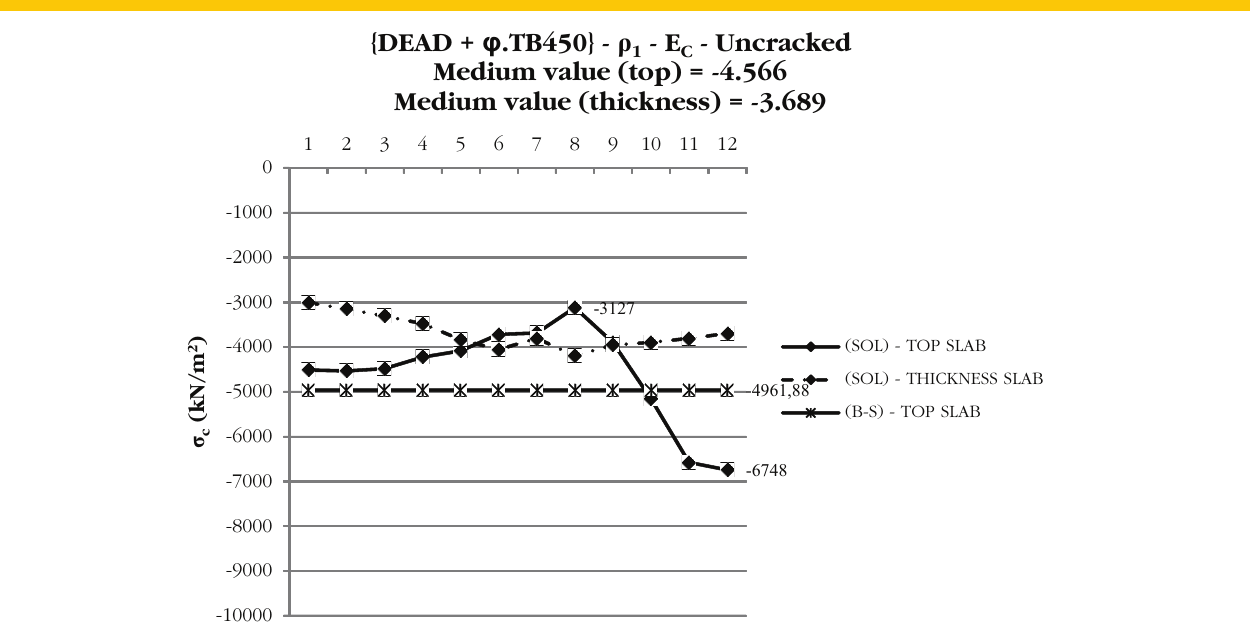
Figure 14 – Distribution of the longitudinal compressive stress – {DEAD + φ .TB450}, uncracked